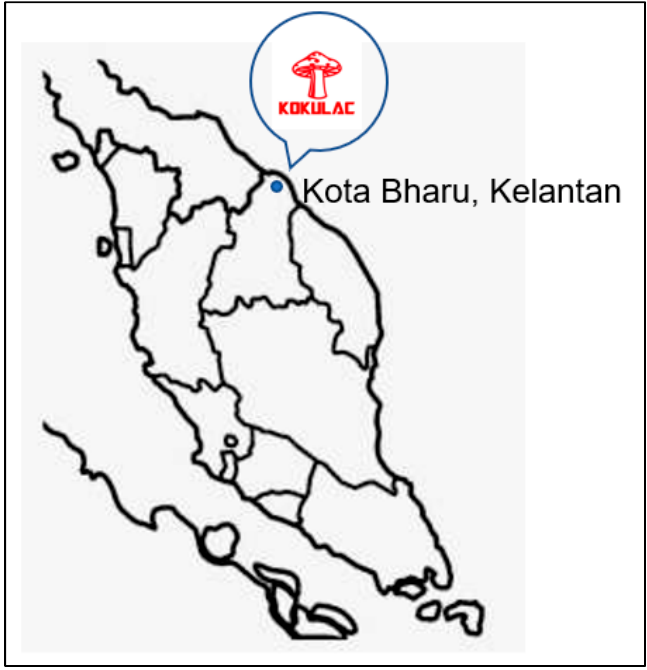
Figure 1. The location of KOKULAC.